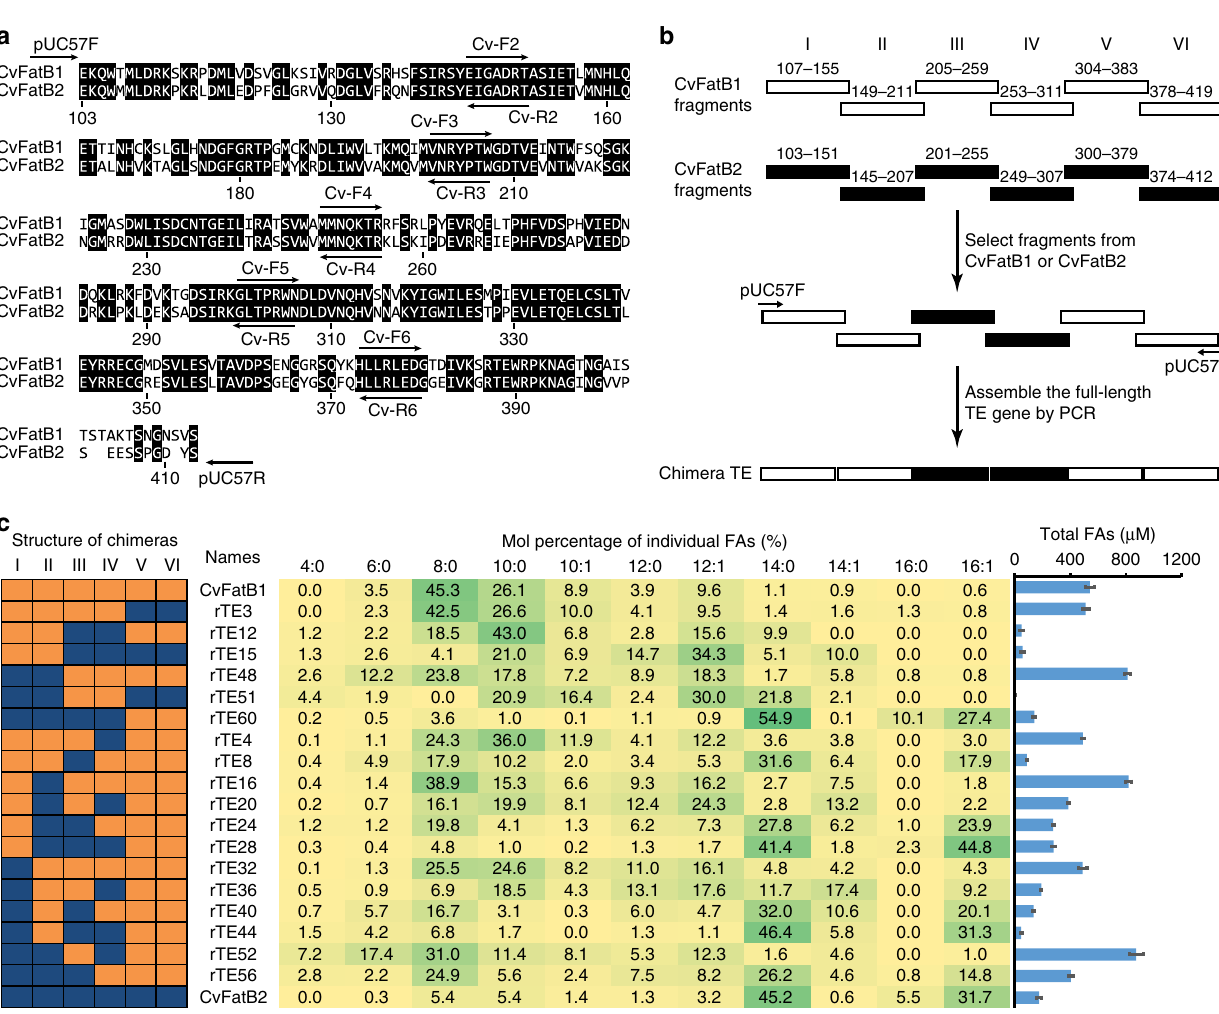
Fig. 1 Domain-swapping to identify segments that determine substrate speci fi city. a Sequence alignment of CvFatB1 and CvFatB2 identifying identical residues shared between the two enzymes, and the positions of DNA primers used to construct chimeric enzymes; b schematic diagram illustrating the construction of chimeric acyl-ACP TEs; c substrate speci fi cities of wild-type and chimeric acyl-ACP TEs. The sequence structures of the chimeric acyl-ACP TEs are presented as different color combinations; orange represents the CvFatB1-sourced fragment, and blue represents the CvFatB2-sourced fragment. The central table shows the fatty acid pro fi le generated by the E. coli strains expressing each chimeric enzyme, and green shading highlights the major fatty acids produced by each chimera. The graph on the right identi fi es the total free FAs accumulated in the medium. The data are the average of four replicates, and the error bar represents standard error of the